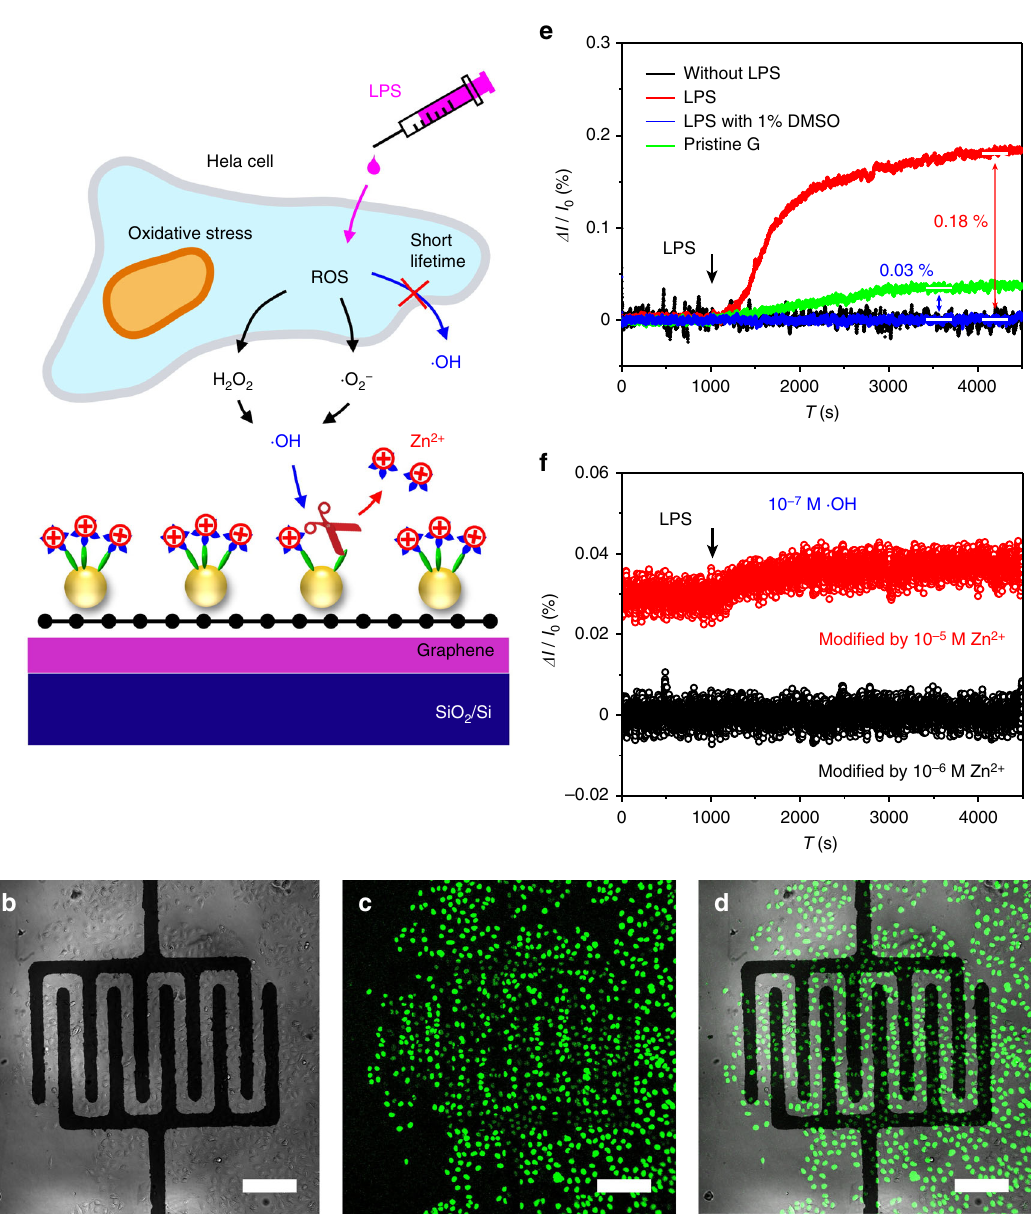
Fig. 5 Real-time detection of (cid:129) OH in living system. a Schematic diagram of the detection of (cid:129) OH produced by Hela cells. b Bright fi eld image, c confocal fl uorescence image (excited by 488 nm laser), and d overlay image of the Hela cells on a fi eld-effect transistor (FET) senor, which indicate that the (cid:129) OH is generated intracellularly after addition of 10 μ g mL − 1 lipopolysaccharide (LPS). e Real-time response of the sensor (or pristine graphene) upon the (cid:129) OH generated from the Hela cells after addition of 10 μ g mL − 1 LPS or 10 μ g mL − 1 LPS with 1% dimethyl sulfoxide. f Real-time response upon the (cid:129) OH generated from the Hela cells after addition of 10 μ g mL − 1 LPS for the FET sensor modi fi ed by 10 − 6 M Zn 2 + (black) or 10 − 5 M Zn 2 + (red). The scale bars in b – d is 200 μ